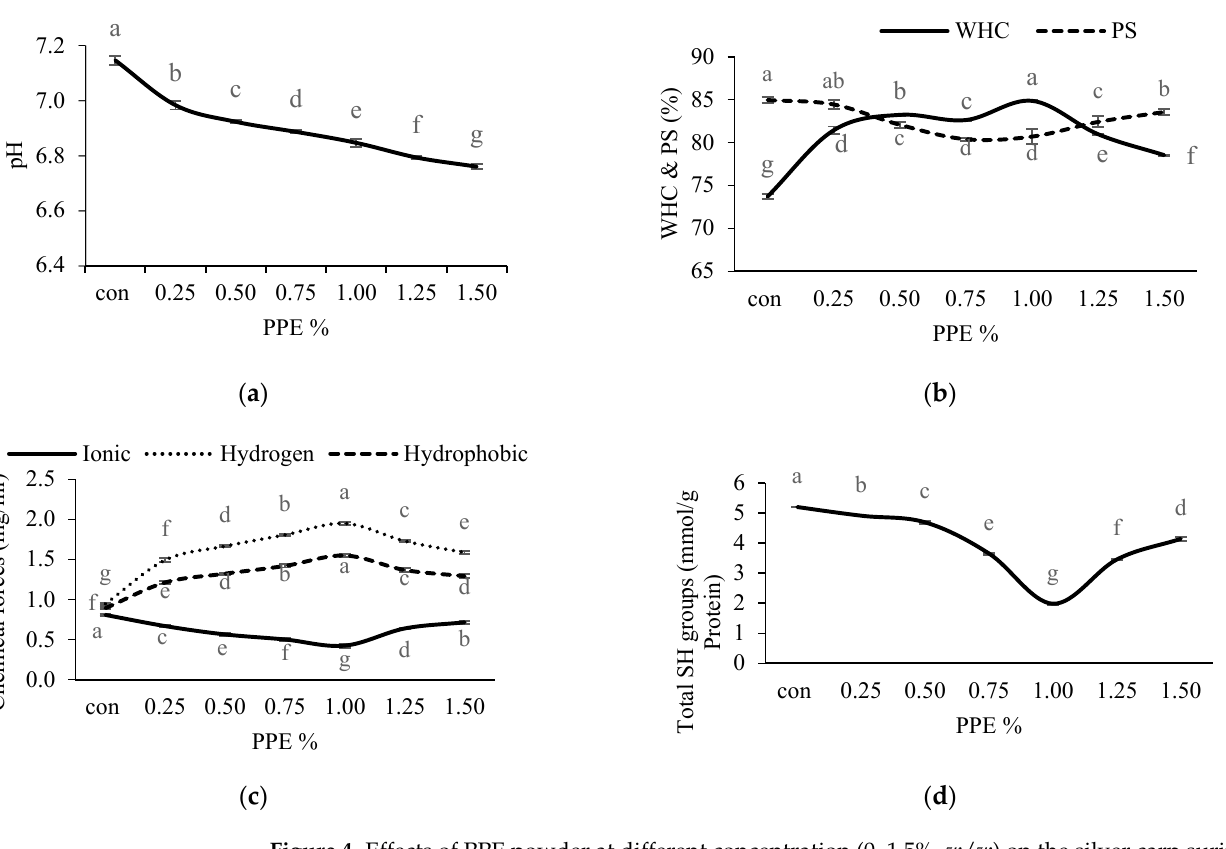
Figure 4. Effects of PPE powder at different concentration (0-1.5%, w / w ) on the silver carp surimi gels pH ( a ), WHC (water holding capacity) and PS (protein solubility) ( b ), chemical forces ( c ), SH groups ( d ). Different letters (a, b, c, etc.) on the bars indicate significant differences ( p < 0.05).